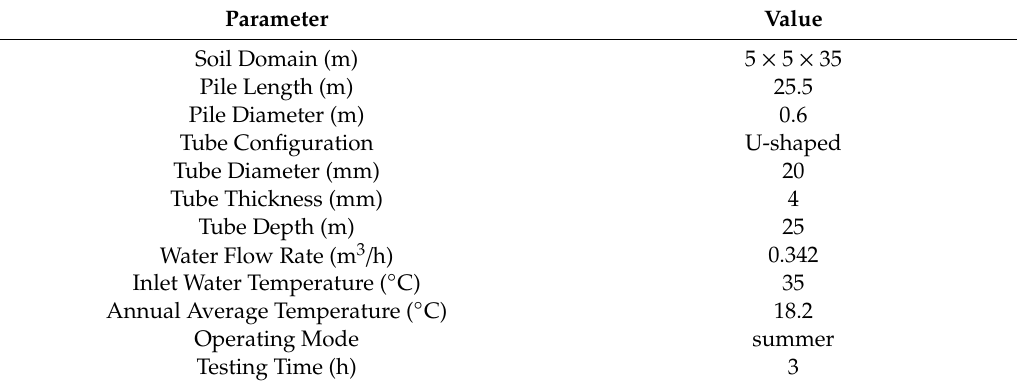
Table 2. Energy pile parameters for Gao et al.’s experiment. [32]. Reprint with permission [4942930442751] from Applied Thermal Engineering; published by Elsevier, Dec. 2008.